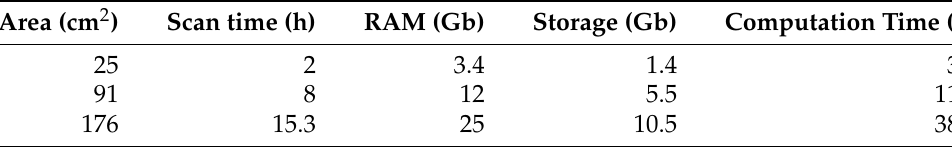
Figure 15. Larger scans. Table 4. Temporal and computational